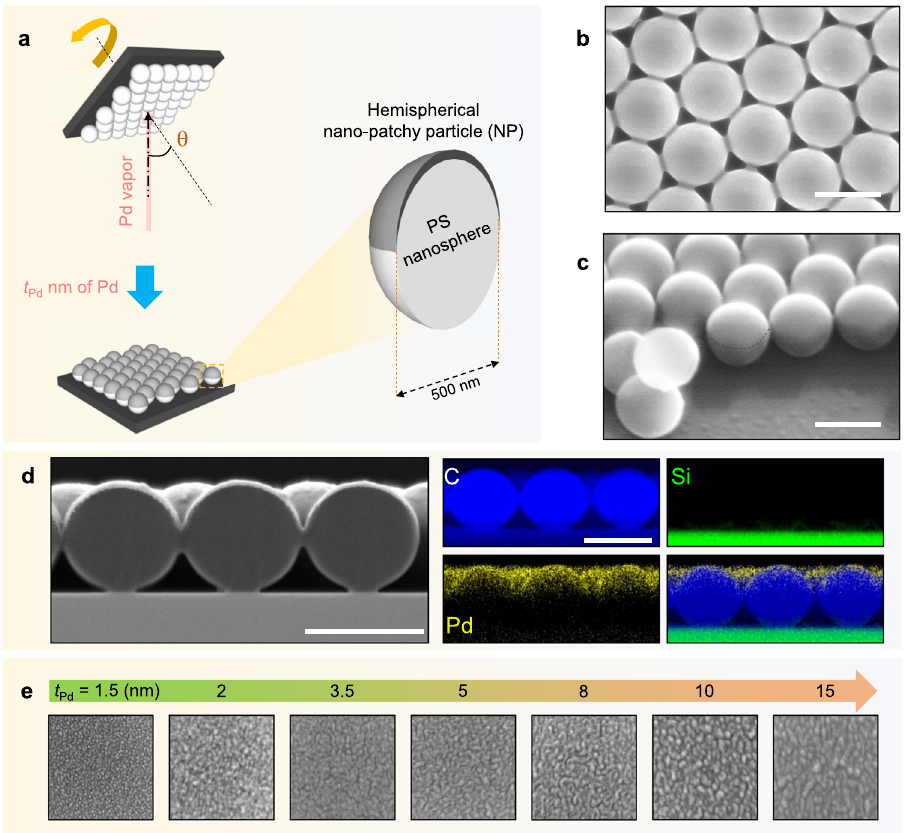
Fig. 1 Fabrication scheme and morphology characterization. a Schematic of the fabrication process. b Top-view and c side-view scanning electron . Scale bars correspond to 500 nm. d Cross-sectional SEM image and EDS elemental maps of NP 50 microscope (SEM) images of Pd NP 50 15 cap formed on the top surface of a PS nanosphere. Scale bars correspond to 500 nm. e Magni fi ed views (150 nm × 150 nm) of ultra-high resolution SEM micrographs (in Supplementary Fig. 8) showing morphology differences of Pd NP with different deposited thickness ( t Pd ) of 1.5 to 15